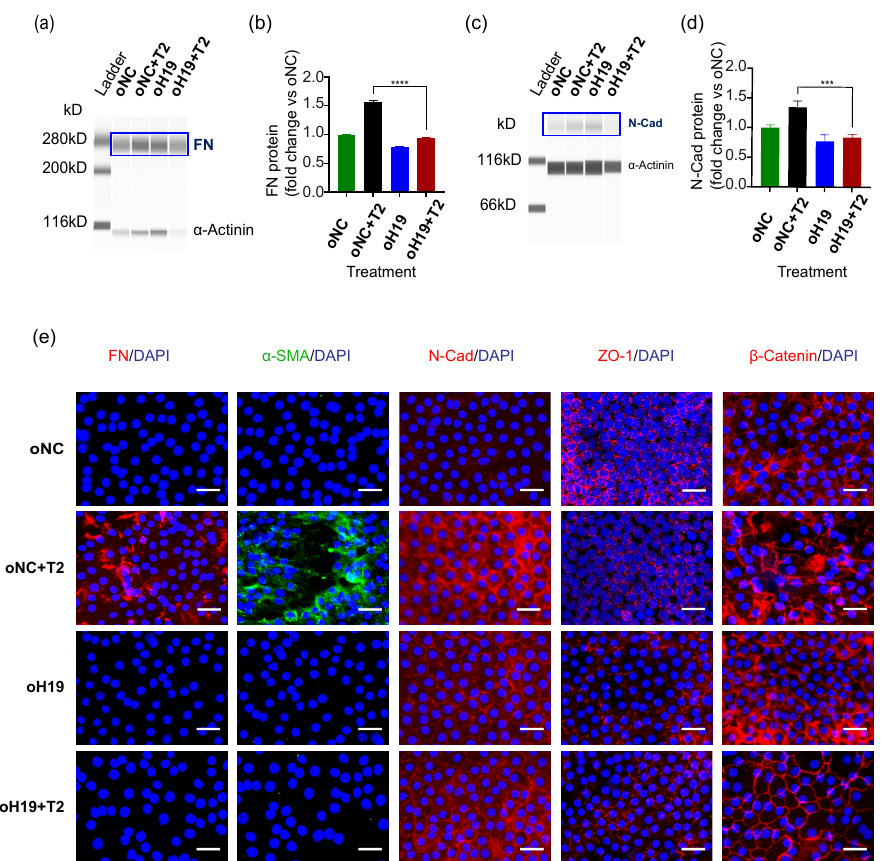
Figure 4. Overexpression of H19 in human lens epithelial cells in situ prevented TGF- β 2-induced EMT. ( a – d ) After infection with H19 -overexpressed lentiviruses for 24 h and further exposure to TGF- β 2 for another 24 h, ProteinSimple Wes platform detected mesenchymal markers, FN, and N-Cad protein levels. ( e ) Immunofluorescent staining of FN, α -SMA, N-Cad, ZO-1, and β -catenin on human LEEs. Scale bars, 20 µ m. *** p < 0.001, **** p <